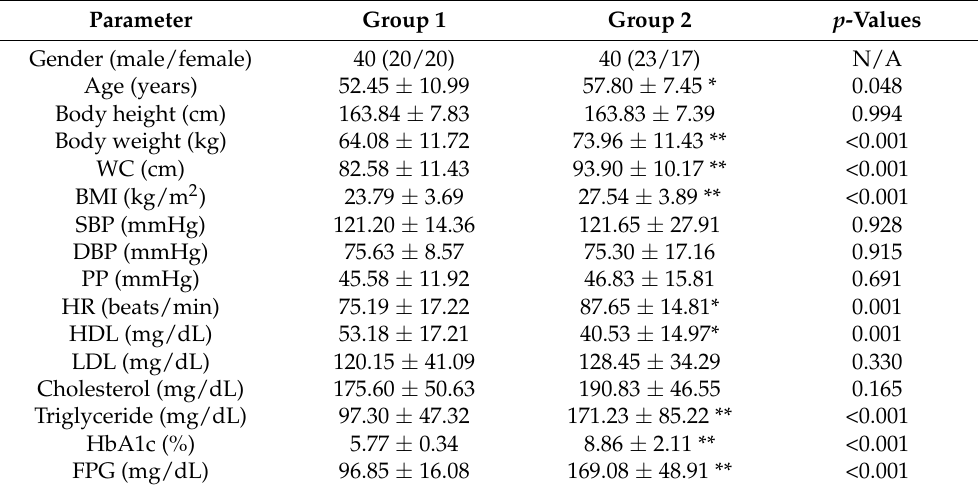
Table 1. Anthropometric and serum biochemical parameters of Group 1 (healthy middle-aged subjects) and Group 2 (type 2 diabetic subjects